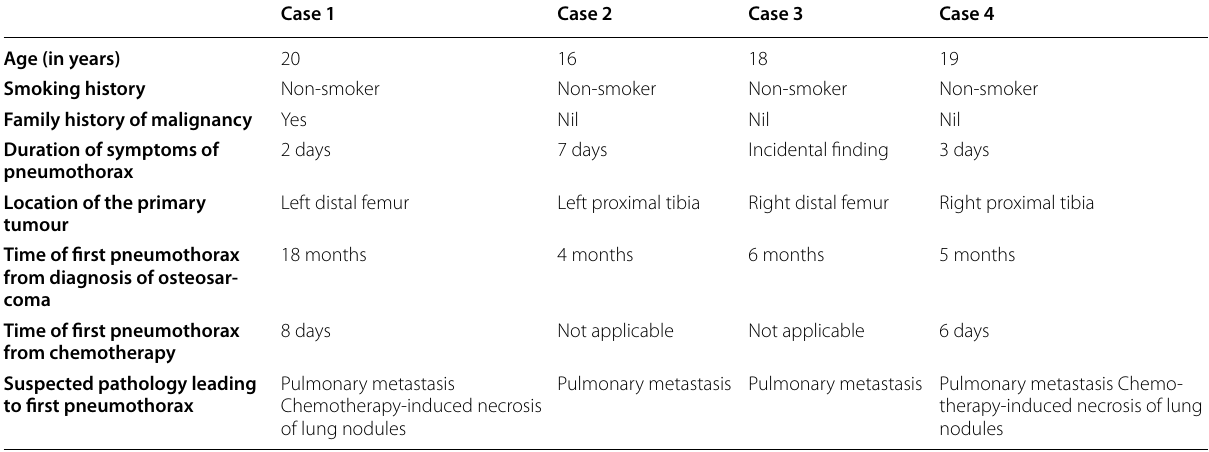
Table 1 Summary of